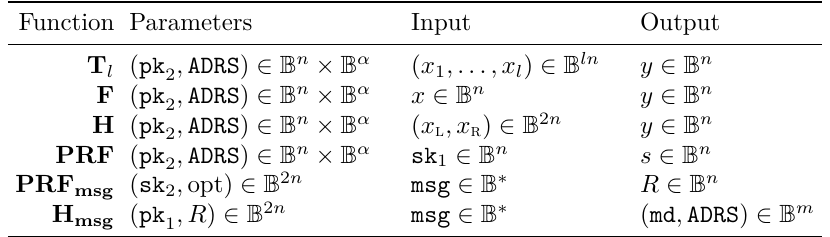
Table 1: Hash functions involved in SPHINCS + .